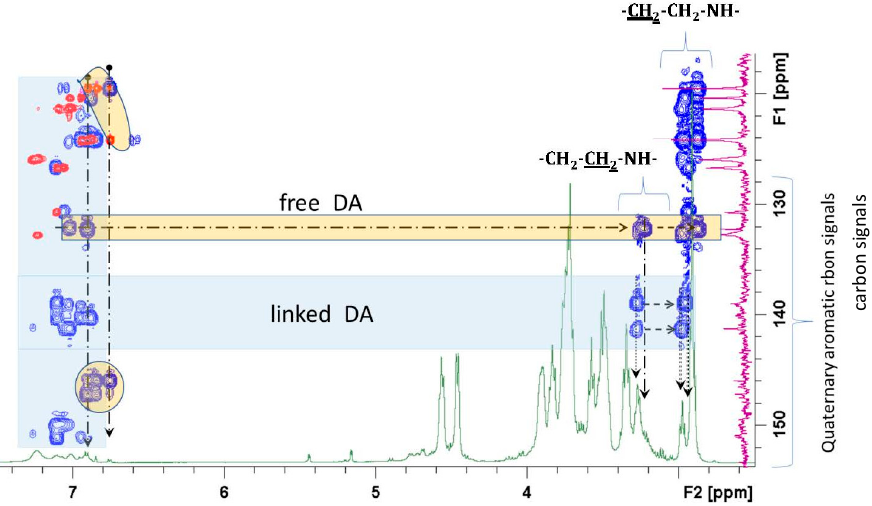
Figure 6. HMBC partial spectrum of HA-DA aromatic quaternary carbon correlation signals ( blue ) superimposed on the HSQC ( red ) and 1 H spectrum ( green ). Correlations of the DA polymeric components are underlined in the light blue areas while the free form is evidenced in the yellow area.